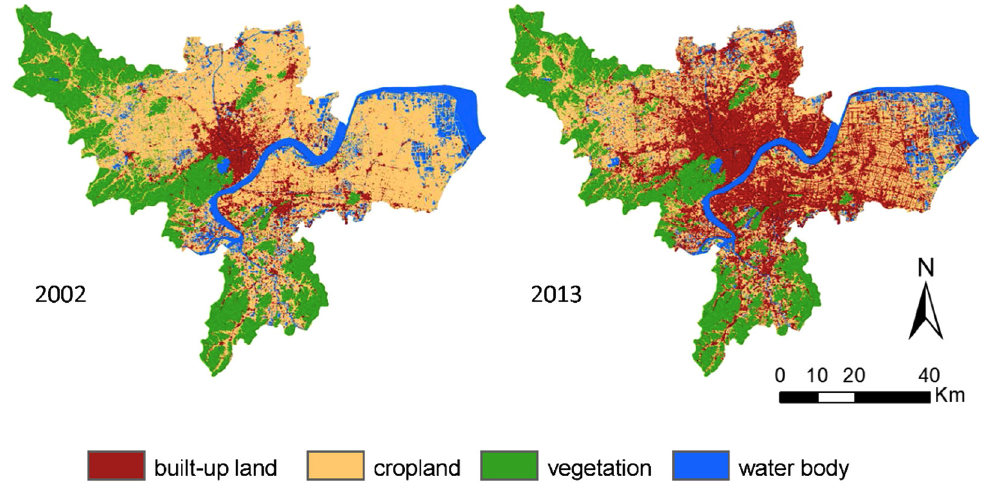
Figure 2. Classified land cover maps of Hangzhou city in 2002 and 2013 Table 3. Land cover statistical data of Hangzhou city Built-up Farmland